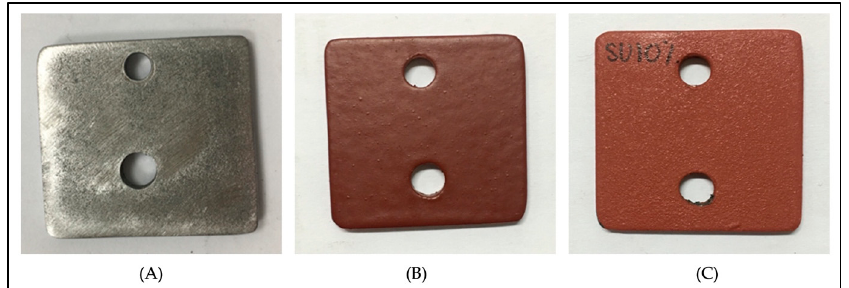
Figure 2. Preparation of panels. ( A ) Uncoated panel. ( B ) Panel coated with anticorrosive primer. ( C ) Panel coated with anticorrosive primer and antifouling extract ( D. setosum or S. lanceolata ). Blank paint with no antifouling agent and commercial antifouling paint, known as reference paint 1 (RF1) and 2 (RF2), received from the industry (provided by a local Oil and Gas company) were used for this study, which act as the negative and positive con- trols, respectively. Blank paint is a mixture of paint consisting of some chemicals, includ- ing: colophony (CAS number: 8050-09-7), xylene (CAS number: 1330-20-7), zinc oxide (CAS number: 1314-13-2), ethylbenzene (CAS number: 100-41-4), hydrocarbons (C9, aro- matic, CAS number: 64742-95-6), 1-methoxy-2-propanol (CAS number: 107-98-2), and fa tt y acids (CAS number: 91001-64-8). Some of the components included in the reference paints are similar to the blank paint, but without fa tt y acids and other ingredients added.